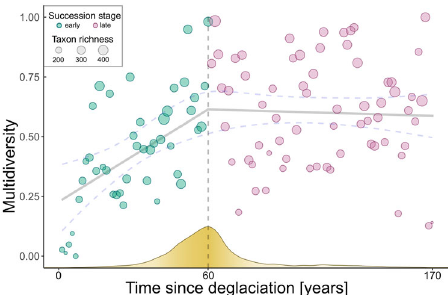
Fig. 1 Multidiversity along the successional gradient. Multidiversity increases during the early successional stage and remains stationary as succession continues. The vertical dashed line indicates the estimated threshold in multidiversity development, which is the threshold in community assembly as predicted by the framework of Chang and HilleRisLambers (2016) 1 . The grey regression line indicates the linear correlation between multidiversity and time since deglaciation using a broken-stick model. Blue dashed lines indicate the 2.5% and 97.5% quantiles of fi tted values. The yellow curve on the x-axis resembles the posterior distribution for the estimate of the breaking point, i.e., higher density of the frequency indicates a higher probability for the breaking point to be located at a given